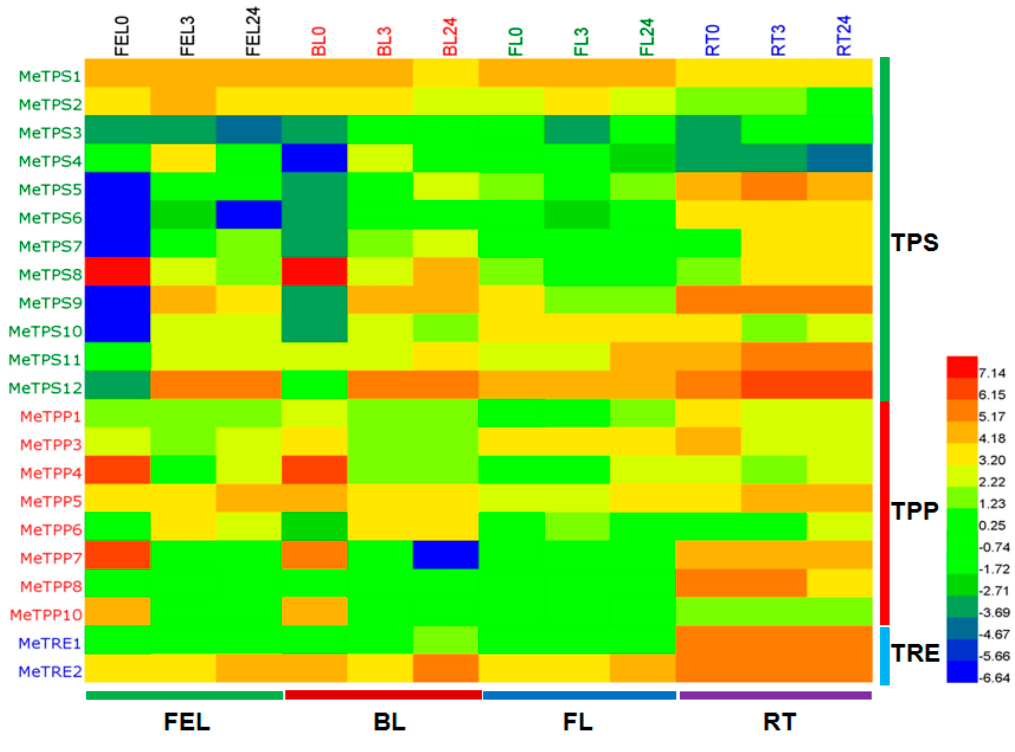
Figure 6. Differential expression of trehalose pathway genes in leaves and roots of cassava in response to 20% PEG treatment. These data came from a previous RNA-seq analysis [6]. The expression levels of trehalose pathway genes in all samples in TPM (Transcripts Per kilobase Million) were compiled with Excel 2007, and normalized using logarithmic method with two as base. The normalized dataset was then exported to HemI toolkit [45], and the figure (Heatmap) was built using the default parameters. The expression levels are represented by different colors as indicated by the scale on the bottom right. FEL, full expanded leaf; BL, bottom leaf; FL, folded leaf; RT, root. FEL0, FEL3, and FEL24 indicate full expanded leaf after 0, 3, and 24 h after PEG treatment, respectively; and the treatment lengths of BL, FL, and RT samples were indicated the same as above.